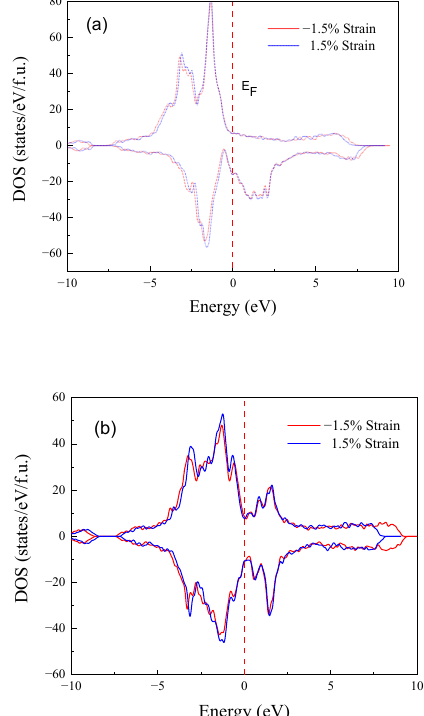
Figure 7. Strain change ( − 1.5%, 1.5%) of the TDOS of Ni 14 Co 2 Mn 13 Sn 3 alloys. ( a ) the austenitic phase. ( b ) the martensitic phase.